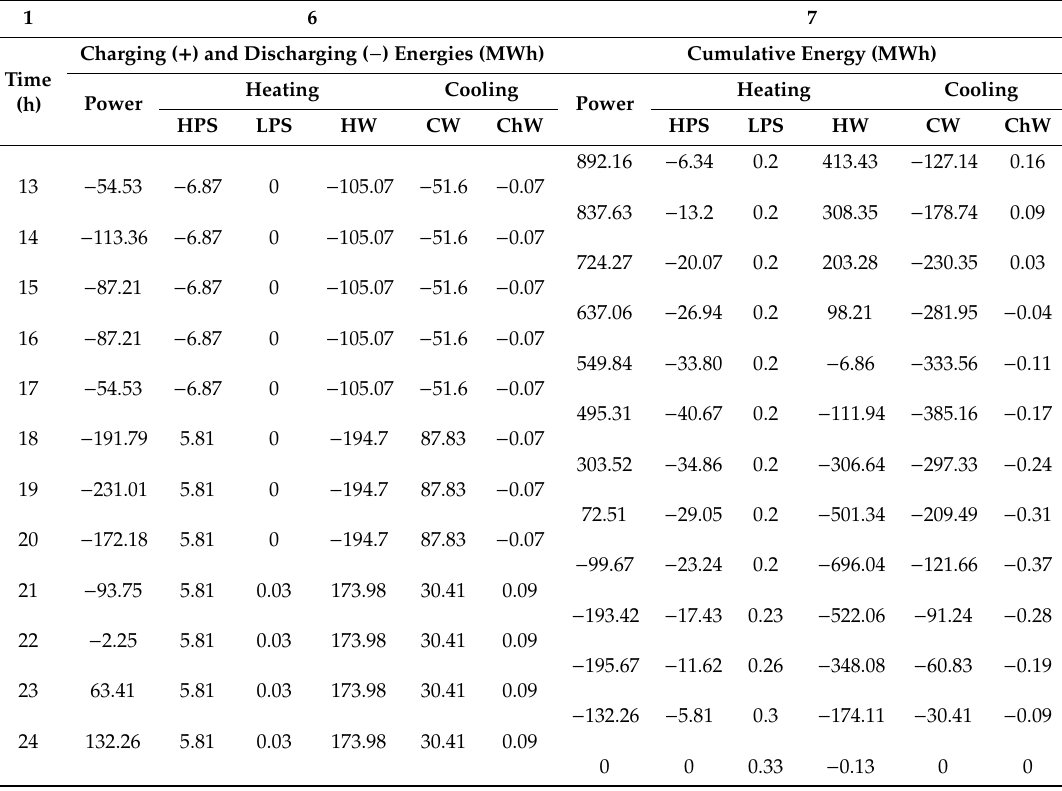
Table A24. TriGenSCA for final trigeneration PWR NPP without integration from time 13 to 24